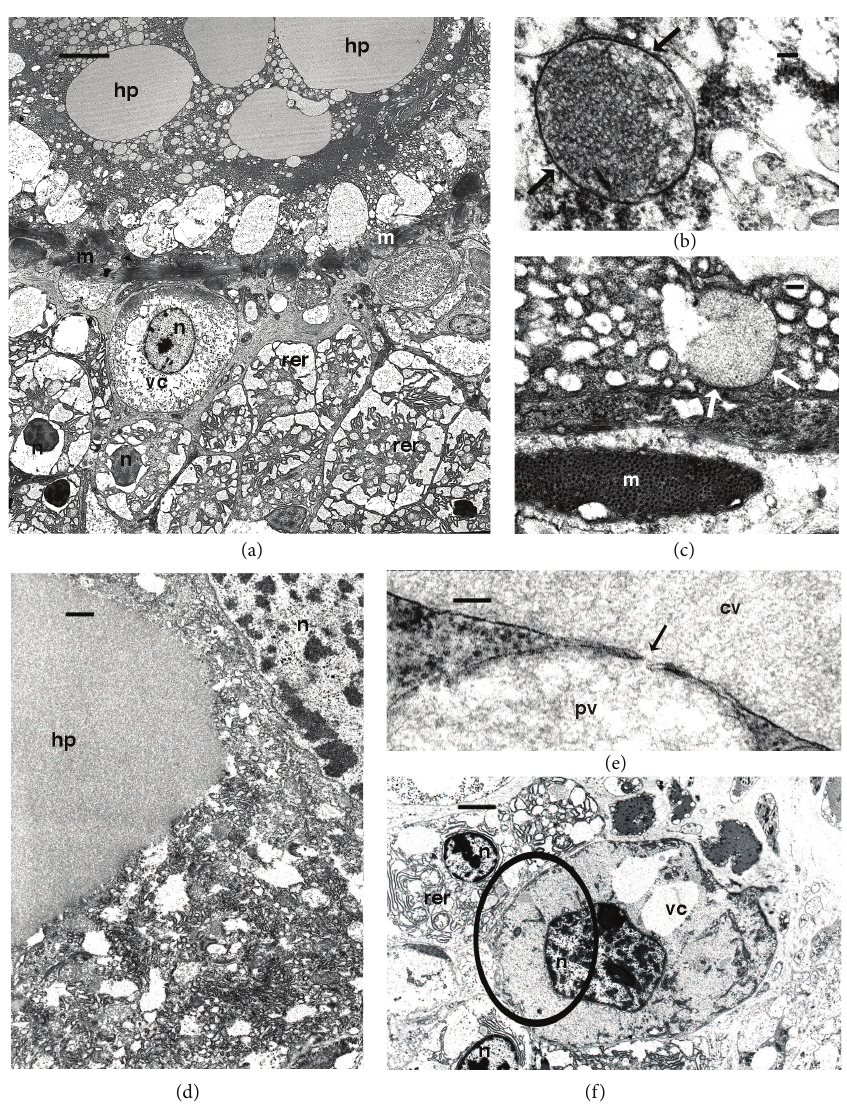
Figure 2: Amber vesicle of Aplysia californica . (a) Vesicle containing large vacuoles of hydrated protein. The amber vesicle is surrounded by cells rich in rough endoplasmic reticulum (RER cells) and is adjacent to a vesicle cell (see also (f)). ((b) and (c)) Protein contained within membrane bound vacuoles (arrows) in an amber vesicle. (d) Amber vesicle nucleus adjacent to the vesicle lumen which is filled with hydrated protein. (e) Fusion of protein vacuole membrane with central vacuole membrane (arrow) that fills the vesicle lumen. (f) Vesicle cell with large nucleus and dense cytoplasm. Circled area enlarged as Figure 3(a). cv, central vacuole; pv, protein vacuole; hp, hydrated protein; m, muscle; n, nucleus; rer, rough endoplasmic reticulum rich cell; vc, vesicle cell. Scale bars: (a) = 5 𝜇 m; (b) = 100nm; (c) = 200 nm; (d) = 1 𝜇 m; (e) = 100nm; (f) = 2 𝜇